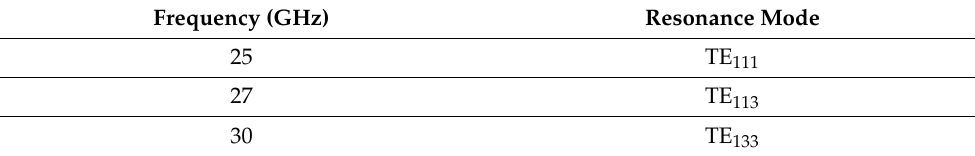
Table 2. Resonance frequencies of a number of TE modes supported by the DRA.